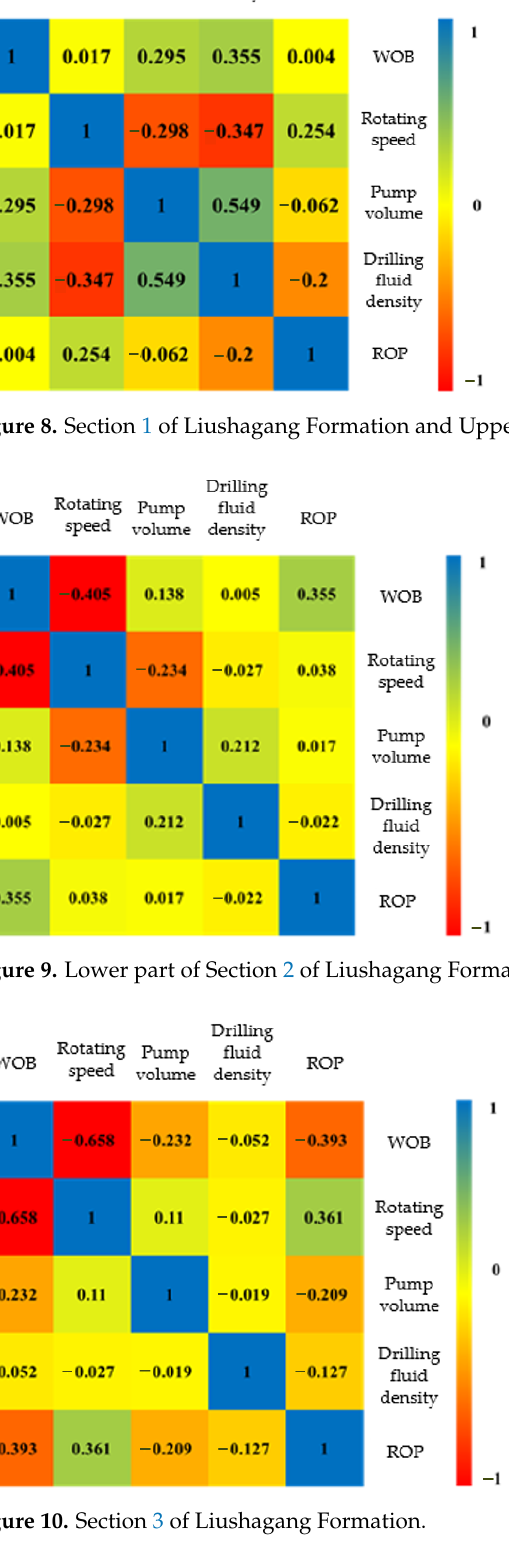
Table 1. Recommended range of main control factors of ROP. Stratum